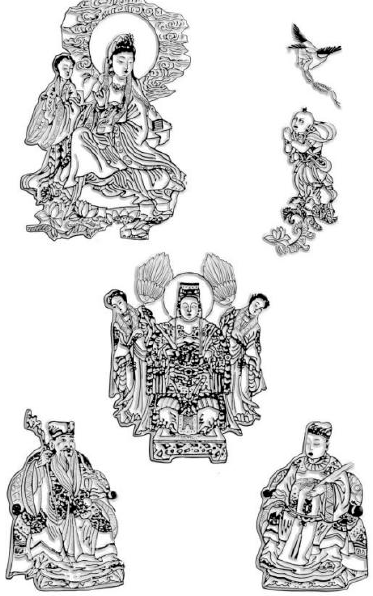
Figure 6. “Guan-yin-ma-lian” (five-in-one